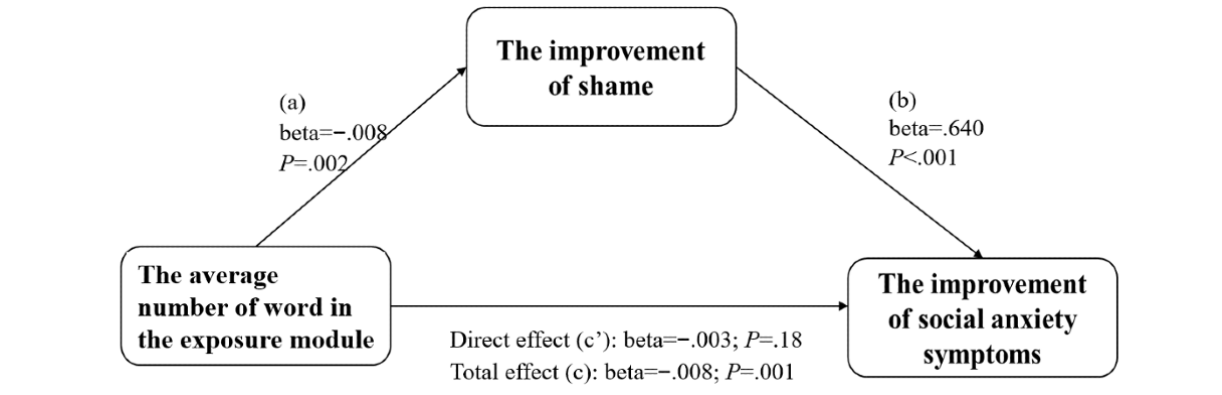
Figure 2. The mediation effect of shame decrease on exposure to Social Interaction Anxiety Scale.